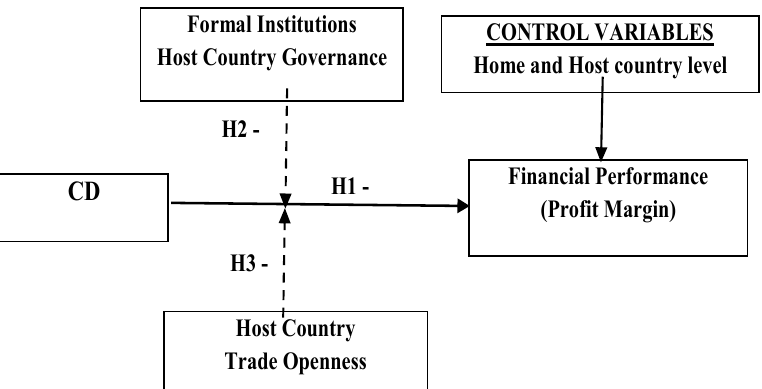
Figure 1. The moderating effects of formal institutions and trade openness on the relationship between CD and financial performance of foreign subsidiaries.